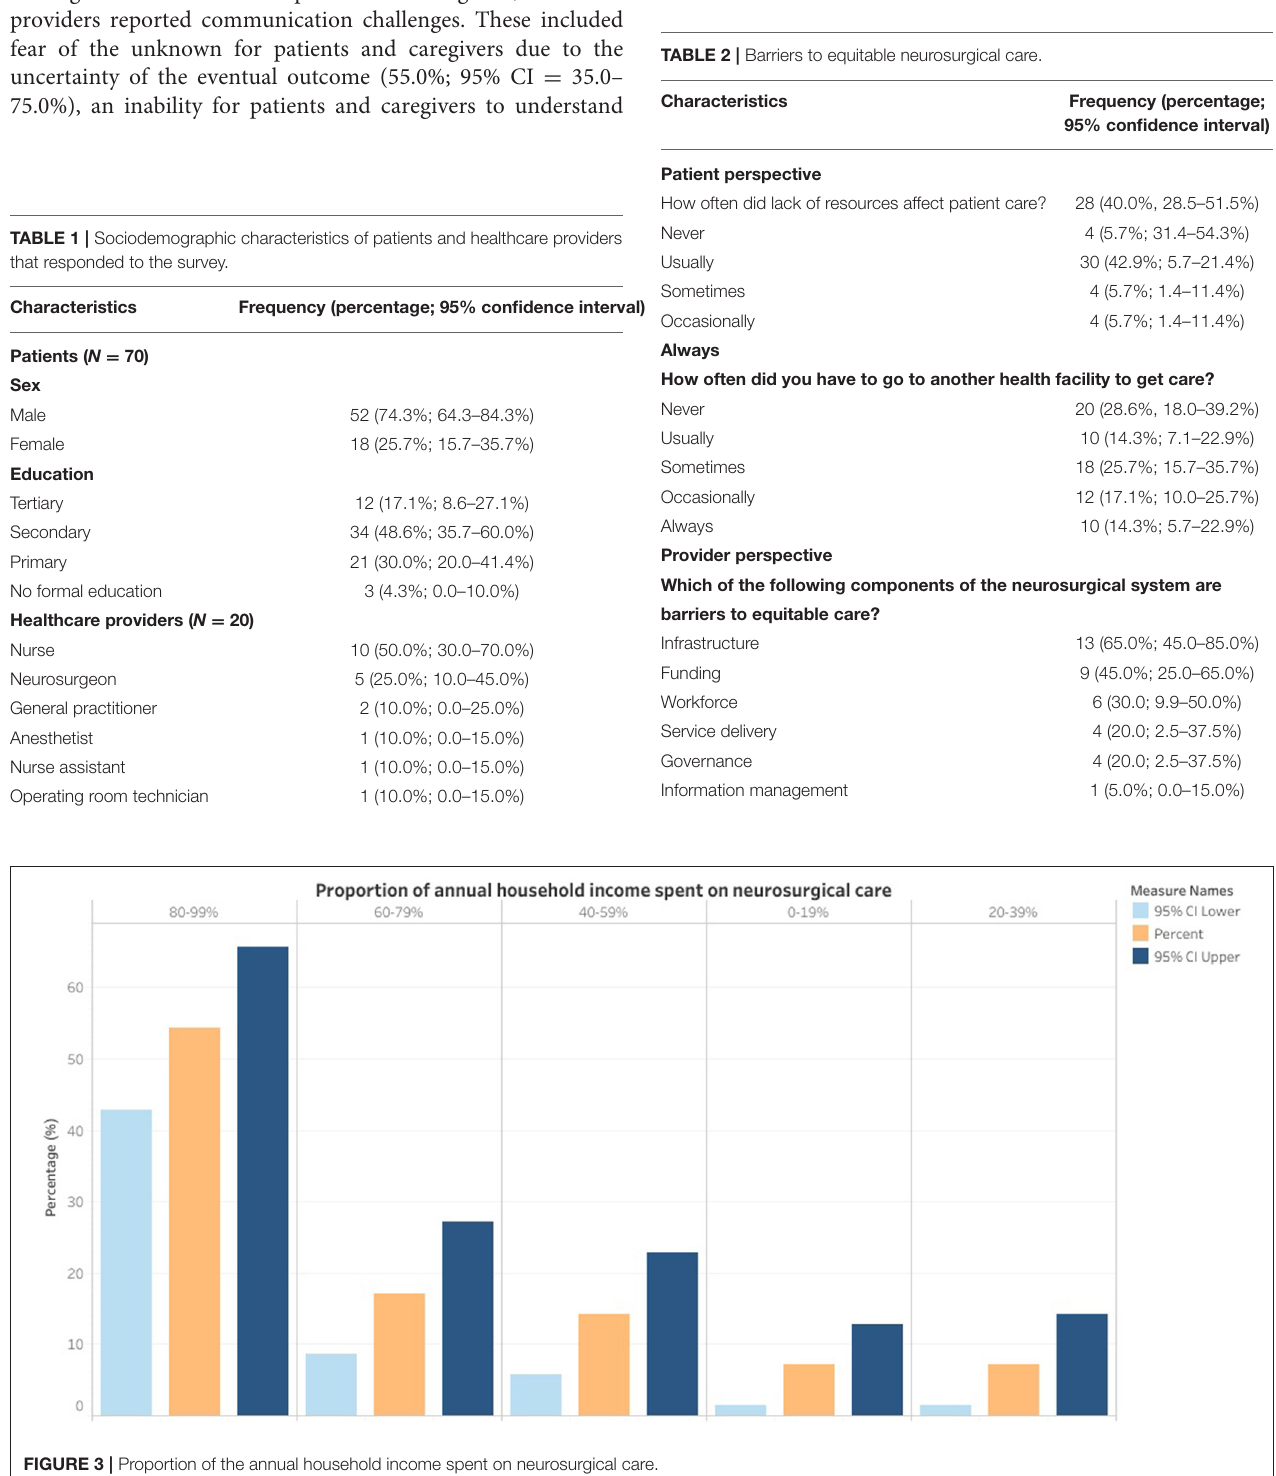
Frontiers in Surgery |